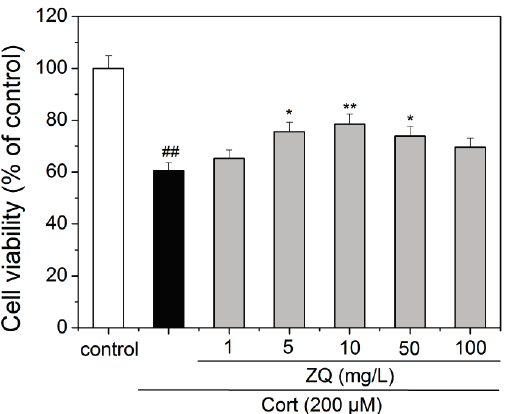
Figure 5. Effect of ZQ on the cell viability in corticosterone-treated PC12 cells. The results are expressed as mean ± SD ( n = 3). ## p < 0.01 as compared with control group; * p < 0.05 and ** p < 0.01 as compared with the corticosterone group. ZQ: ZQ aqueous extract; Cort: corticosterone.